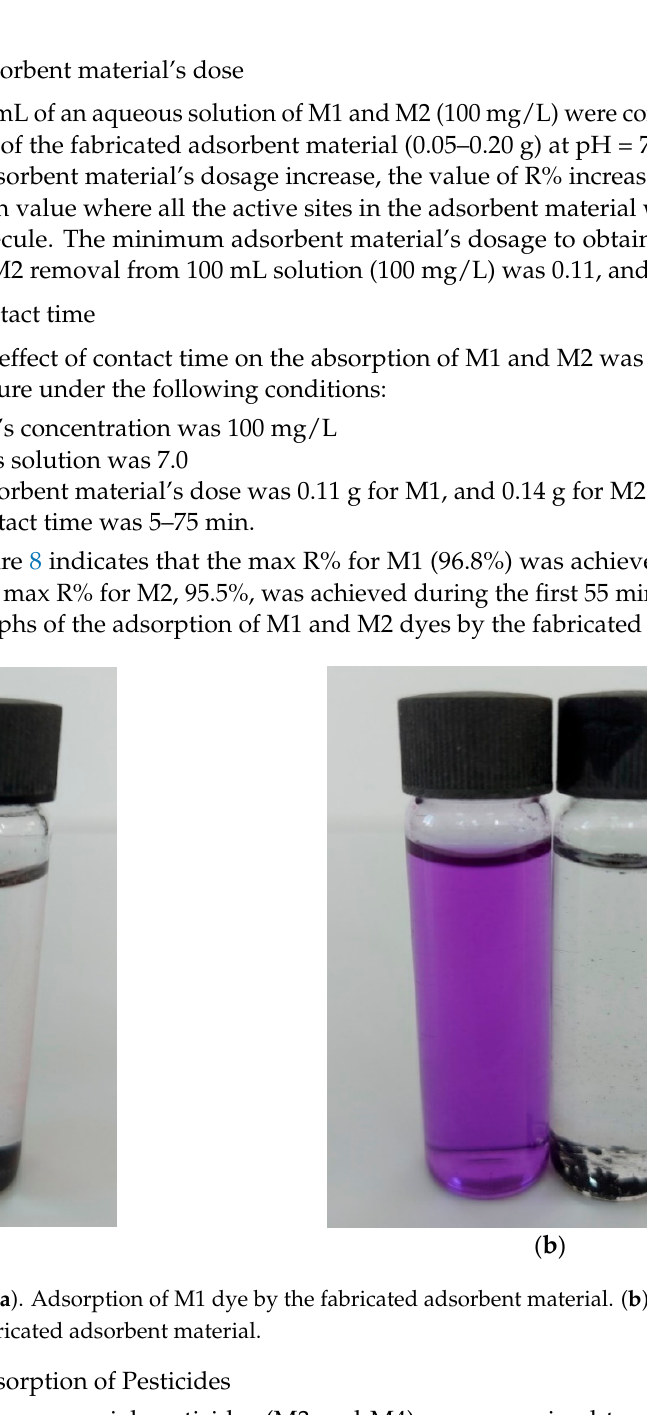
Figure 7. The UV-Vis spectra of M1 and M2 in aqueous solution (10 mg/100 mL) at pH = 7.